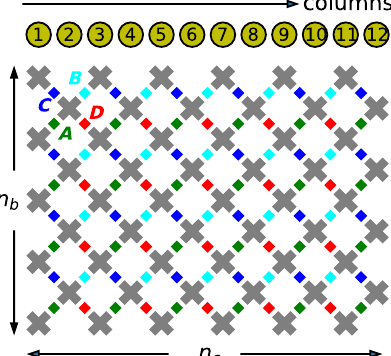
FIG. 1. Topology of the “quantum processor” simulated in this work. The system has n c columns containing alternatively n b and n b − 1 qubits. Here n c = 12 with n b = 5 corresponds to a 54-qubit planar processor that has the same topology as the Sycamore chip. The qubits have nearest-neighbor connectivity. In the quantum circuits corresponding to sequences I and II (see the text), the circuit is split into layers. In each layer, one applies a two-qubit gate between all the pairs of qubits coupled by a green rectangle ( A layers), a light blue rectangle ( B layers), a dark blue rectangle ( C layers), or a red rectangle ( D